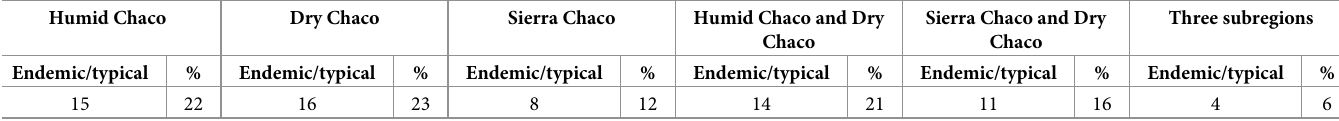
Table 9. Endemic and typical specific and infraspecific taxa of Legumes from Gran Chaco per subregion (% over total taxa of each subregion). Humid Chaco Dry Chaco Sierra Chaco Humid Chaco and Dry